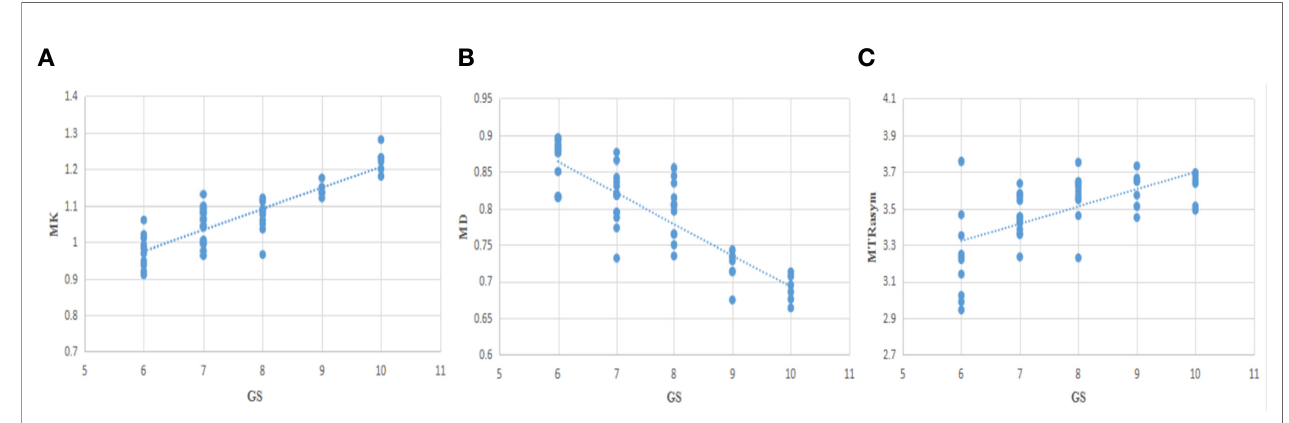
FIGURE 6 | The correlation between MK/MD/MTRasym (3.5 ppm) and Gleason Scores (GS) (A − C) , r=0.844, − 0.811, 0.640,